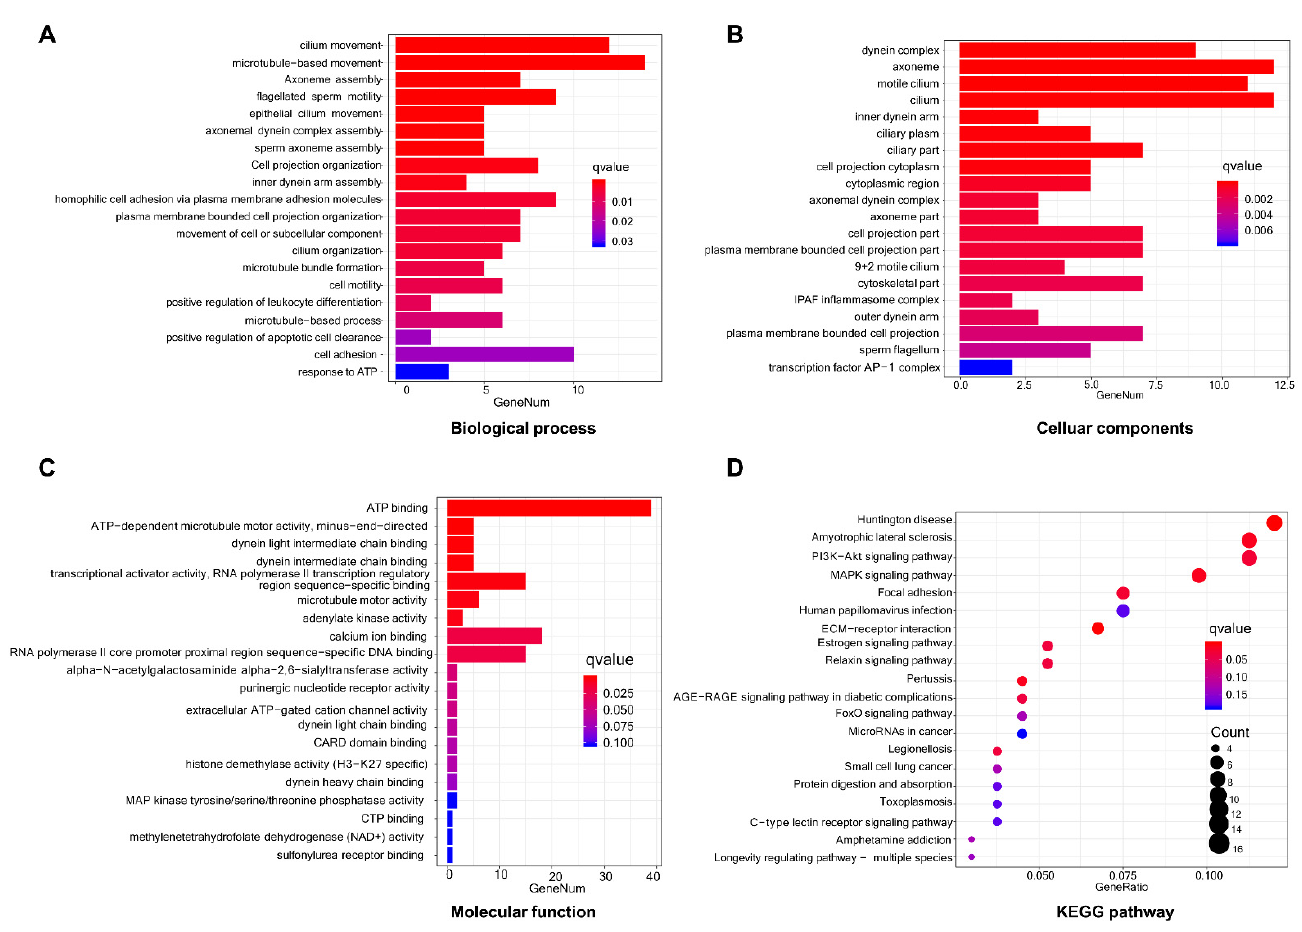
Figure 3. GO and KEGG enrichment analysis of DEGs. ( A – C ) Representative columns of GO analysis belonging to biological process ( A ), cellular components ( B ), and molecular function ( C ) category. ( D ) The top 20 enriched pathways of DEGs via KEGG enrichment analysis. GO: Gene Ontology; KEGG: Kyoto Encyclopedia of Genes and Genomes.